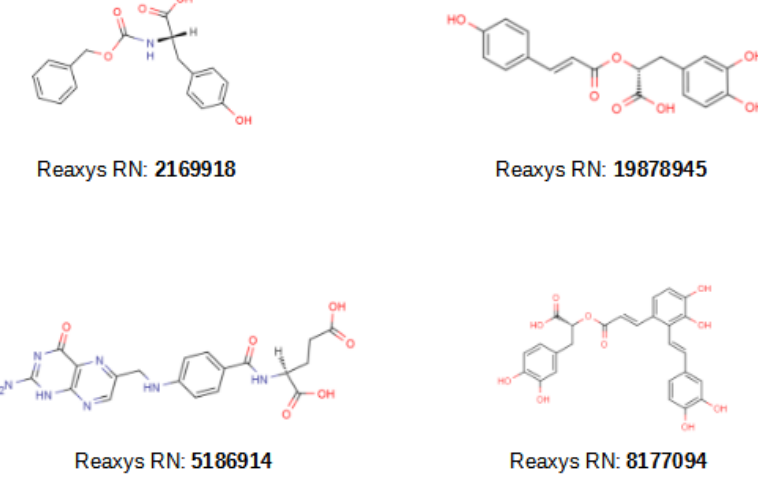
Figure 4. 2D structures of the 4 natural hit compounds with either known MMP inhibitor bioactivity (i.e., 2169918 and 19878945 ) or known application as dermatological agents for skin applications (i.e., 5186914 and 8177094 ). Each compound is identified with its Reaxys register number (Reaxys RN). MarvinSketch [38] was used to draw the structures.